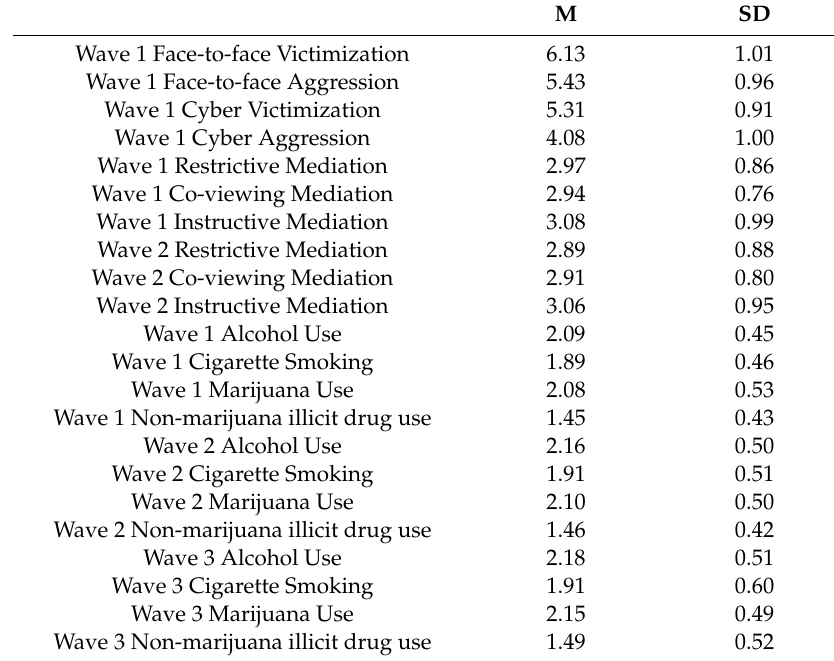
Table 1. Descriptive statistics for face-to-face victimization, face-to-face aggression, cyber victimization, cyber aggression, parental mediation, and substance